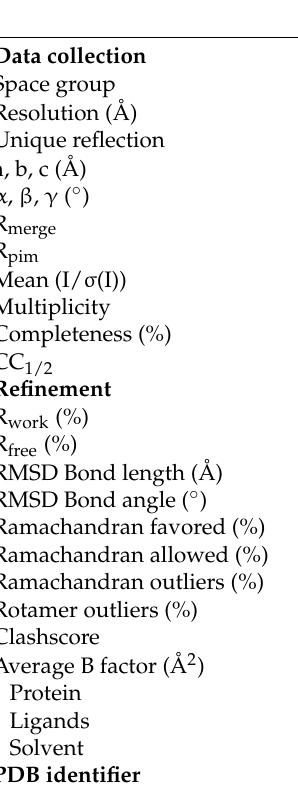
Table 2. Crystallographic data and refinement statistics. Data for the highest-resolution shell are in